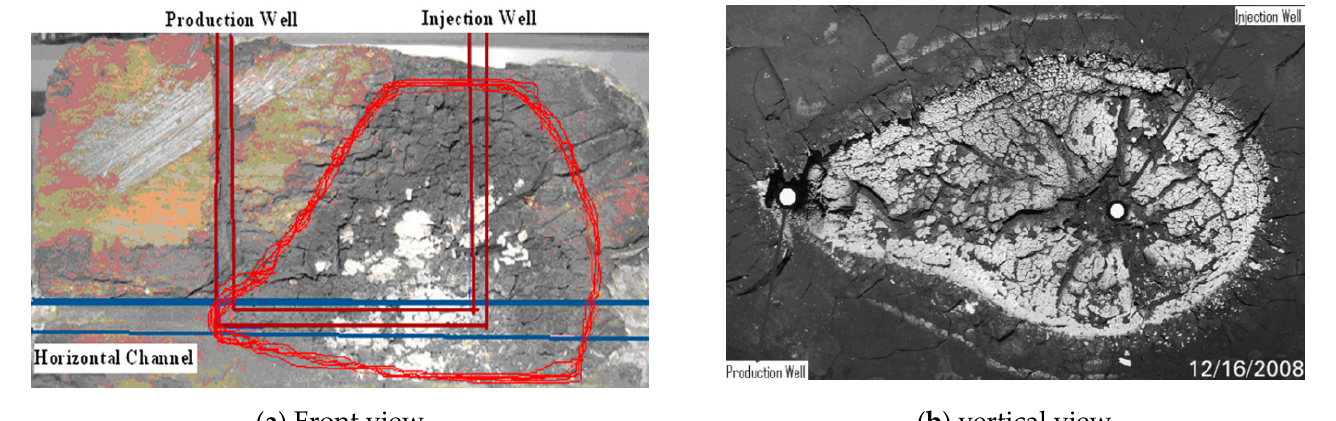
Figure 8. Cavity growth behavior of LVW technology (from [30,31]).